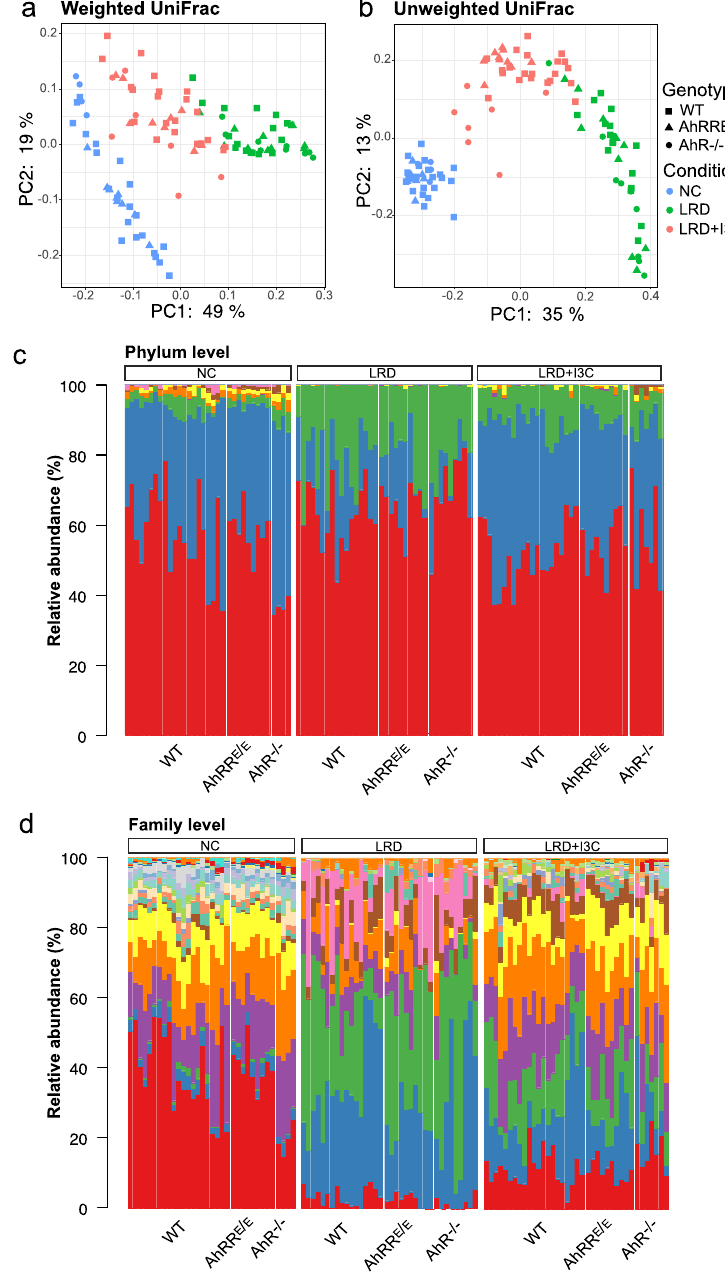
Figure 4. Fecal microbiota differ profoundly between mice fed NC, LRD, or LRD + I3C. Wild-type (WT), AhRR E/E , and AhR −/− mice were fed for four weeks from weaning onwards with normal chow (NC), AhR ligand reduced diet (LRD), or LRD supplemented with indole-3-carbinol (LRD + I3C) (2 g/kg). Fecal samples were analyzed by 16S rRNA sequencing. ( a ) Weighted and ( b ) unweighted UniFrac principal component analysis (PCA). ( c ) Relative abundance of microbial communities on phylum level and ( d ) relative abundance of microbial communities on family level. n = 21 WT mice fed NC, n = 17 WT mice fed LRD, and n = 21 WT mice fed LRD + I3C; n = 9 AhRR E/E mice fed NC, n = 10 AhRR E/E mice fed LRD, and n = 10 AhRR E/E mice fed LRD + I3C; n = 4 AhR −/− mice fed NC, n = 9 AhR −/− mice fed LRD, and n = 7 AhR −/− mice fed LRD + I3C.